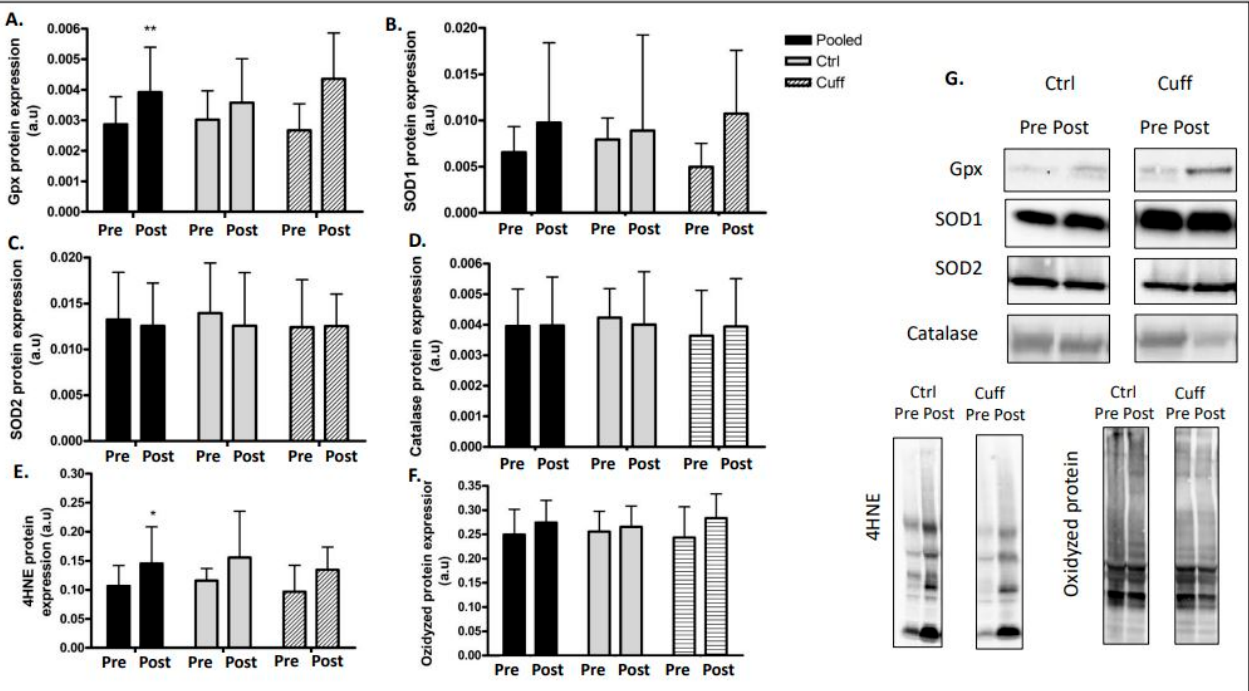
Figure 9. Enzymatic antioxidant defenses and oxidative damages after 5 days of DI. Enzymatic antioxidant defenses access by western blot analysis. ( A ) Gpx protein expression. ( B ) SOD1 protein expression. ( C ) SOD2 protein expression. ( D ) Catalase protein expression. ( E ) 4HNE protein expression. ( F ) Oxydized protein expression. ( G ) Western blot picture analyzed by groups. * different from pre value in the same group. * p < 0.05; ** p <